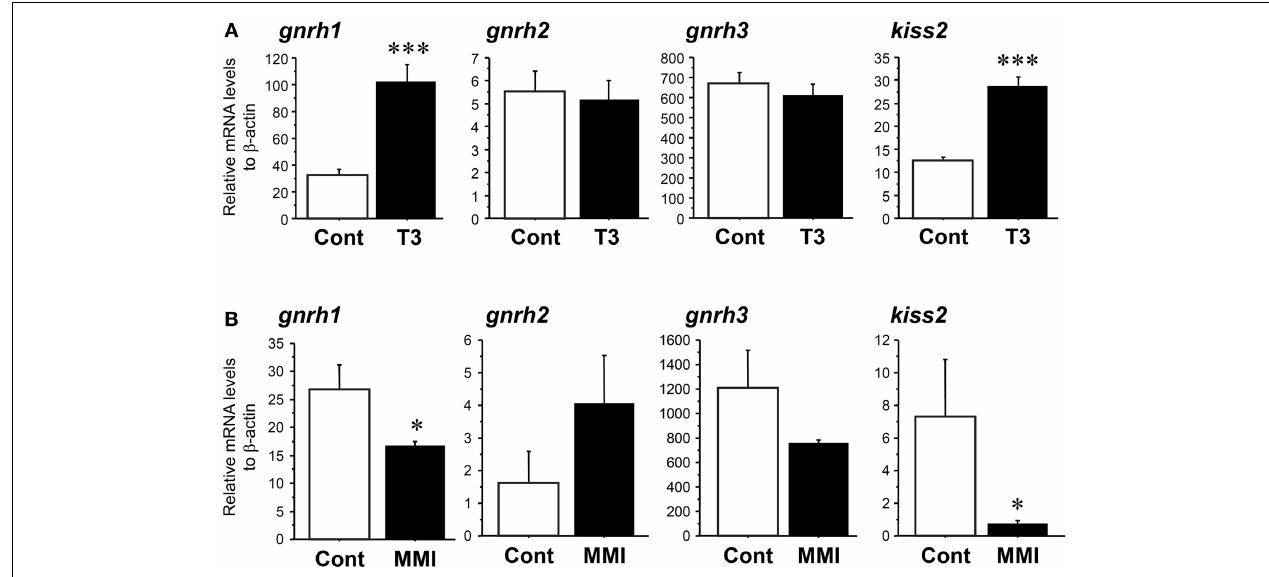
were significantly decreased.There were no effects of manipulation of thyroid hormone on gnrh2 and gnrh3 mRNA levels ( n = 5–8).The relative abundances of the mRNA were normalized to the amount of β -actin using the comparative threshold cycle method. * P < 0.05; *** P < 0.001 vs. controls.